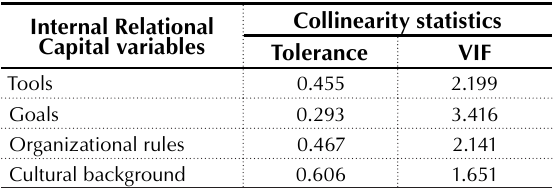
Table 4. Collinearity diagnosis on IRC variables